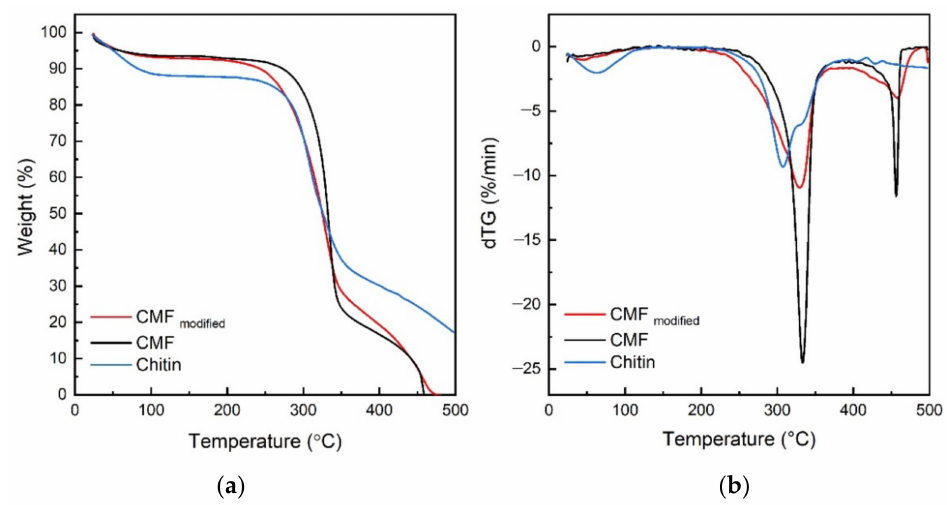
Figure 5. TGA ( a ) and dTG ( b ) curves of CMF modified , CMF, and chitin.